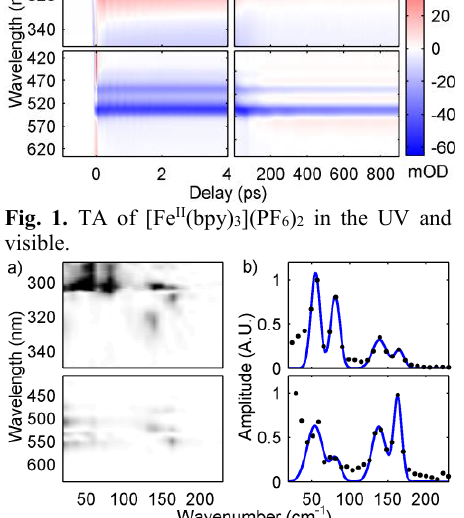
Fig. 4. Static diffraction pattern of [Fe II (bpy) 3 ](PF 6 ) 2 (left) and difference diffraction pattern averaged from 10-50 ps